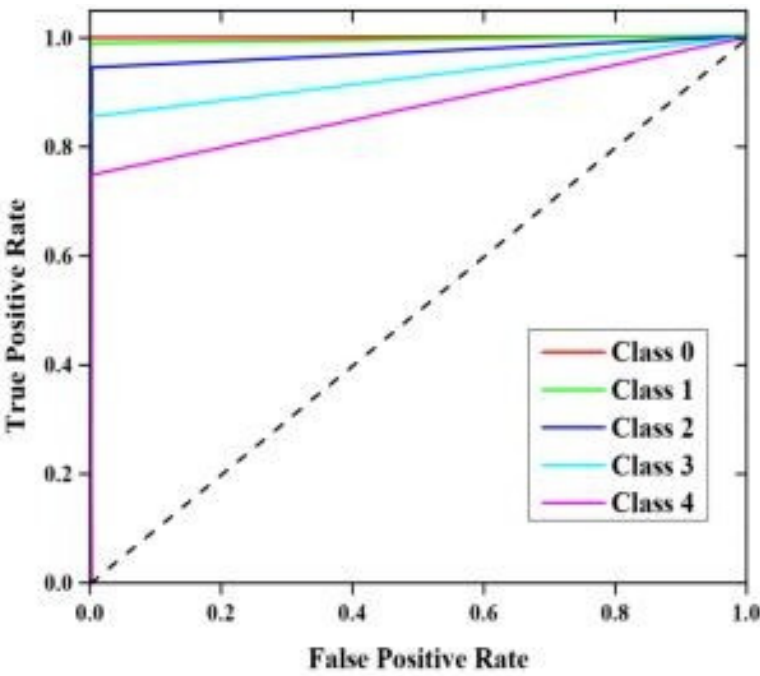
Figure 17. Simulation results based on the execution time and the cache hit rate.